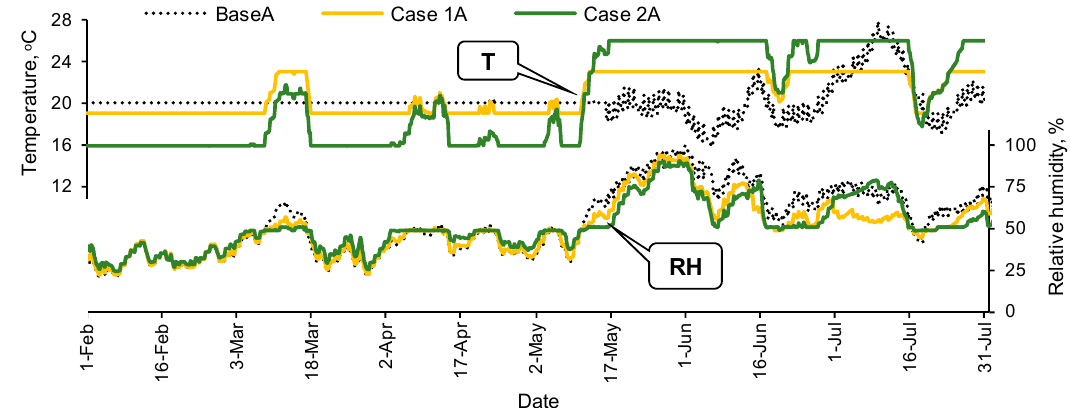
Figure 6. Variation in the indoor relative humidity and temperature in the ethnography hall for cases without additional ventilation for the period of February to July.